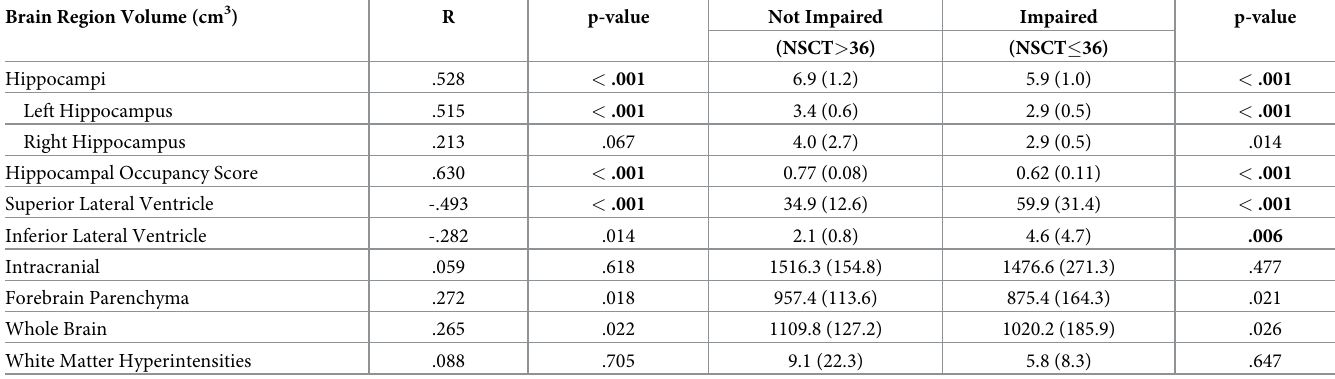
Table 4. Number Symbol Coding Task and volumetric MRI measures.